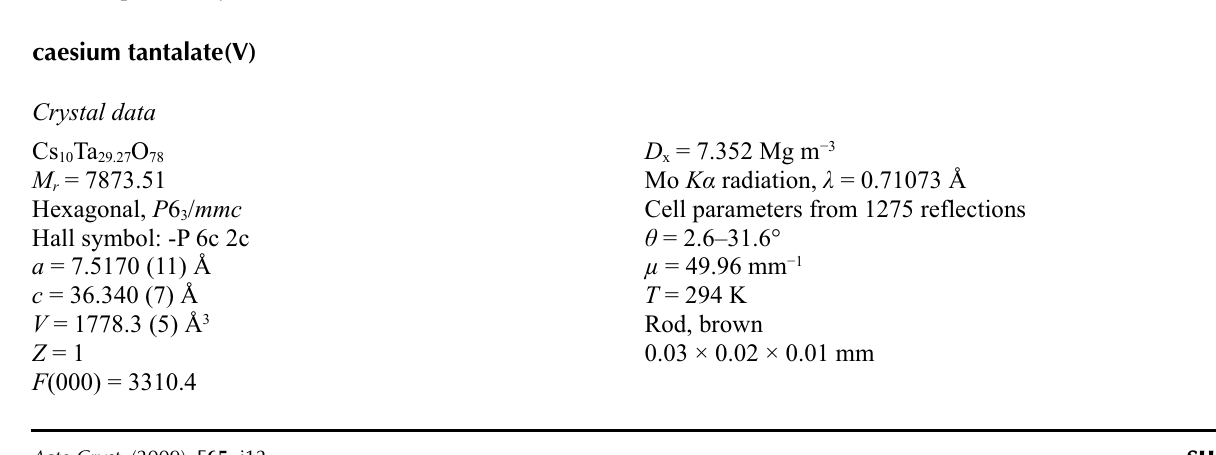
View along [010] on the layers of the title compound connected via TaO the 50% probability